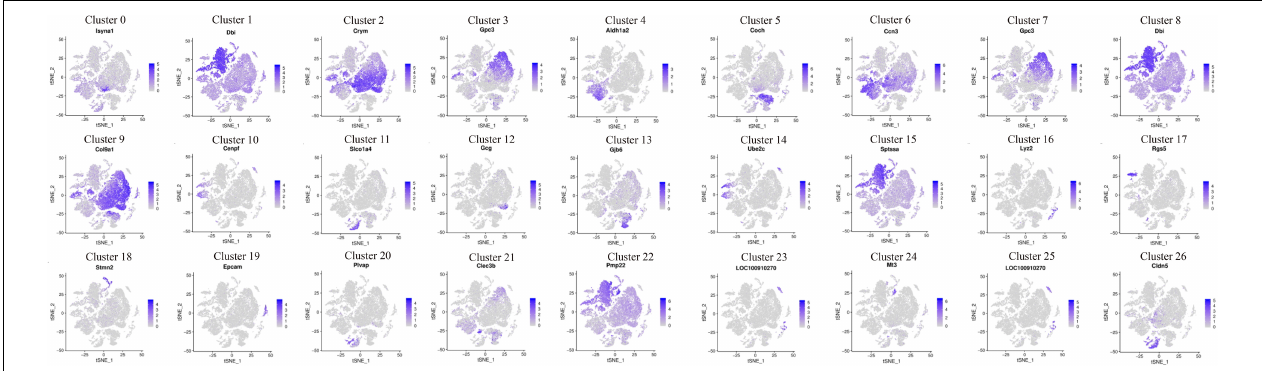
FIGURE 2 | Cochlea cells landscape revealed by scRNA-seq analysis. scRNA-seq was performed on single-cell suspensions pooled from P1 and P7 cochlea duct. All samples were analyzed using canonical correlation analysis with the Seurat R package. Cells were clustered using a graph-based shared nearest-neighbor clustering approach plotted by tSNE plot. Feature Plots of the most abundant gene in each cell cluster of cochlea